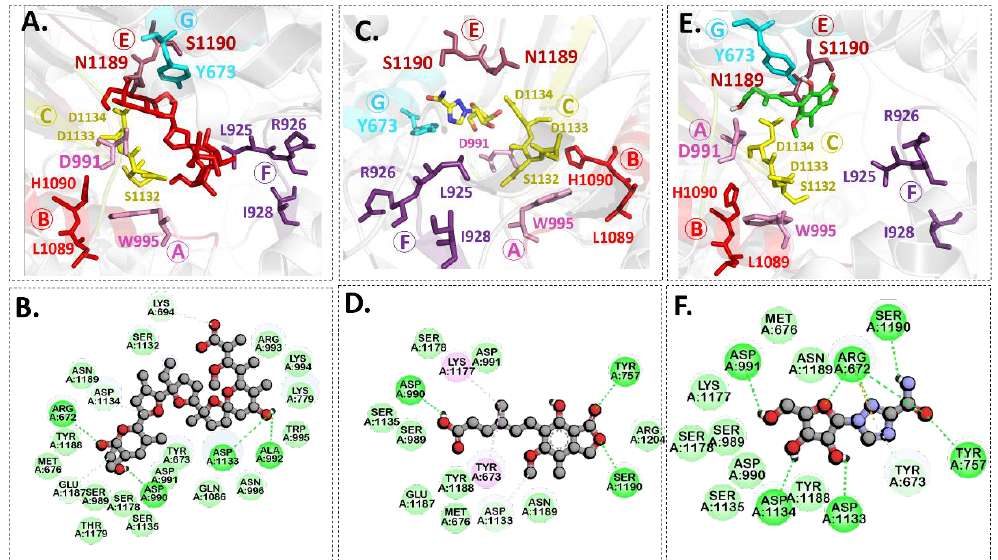
Figure 3. Binding modes and interaction mechanisms of known L protein inhibitors. Close-up view into 3D binding mode of ( A ) Monensin, ( C ) Mycophenolic acid, and ( E ) Ribavirin. The main residues that involve in the formation of the active site within the structurally conserved RdRp motifs that are show in in stickes. 2D interaction analysis of ( B ) Monensin, ( D ) Mycophenolic acid, and ( F )